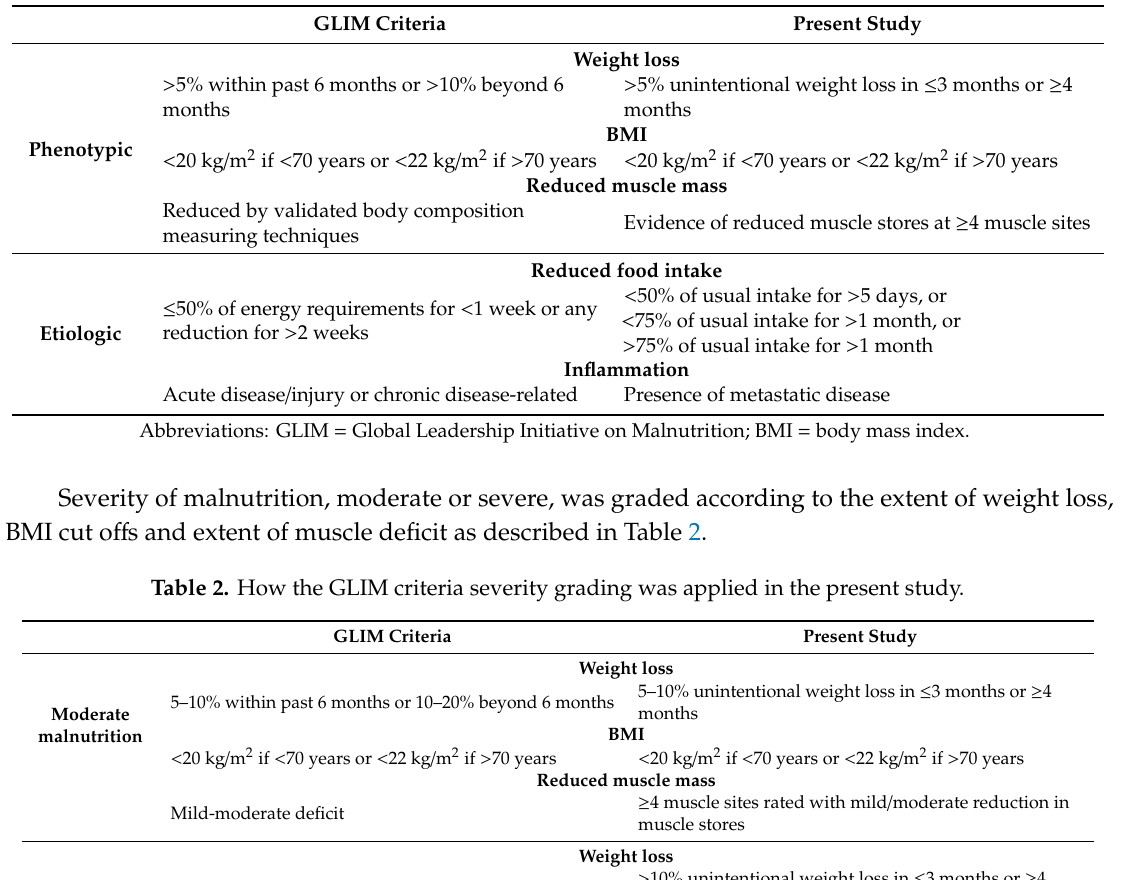
Table 1. How the GLIM criteria were applied in the present study.